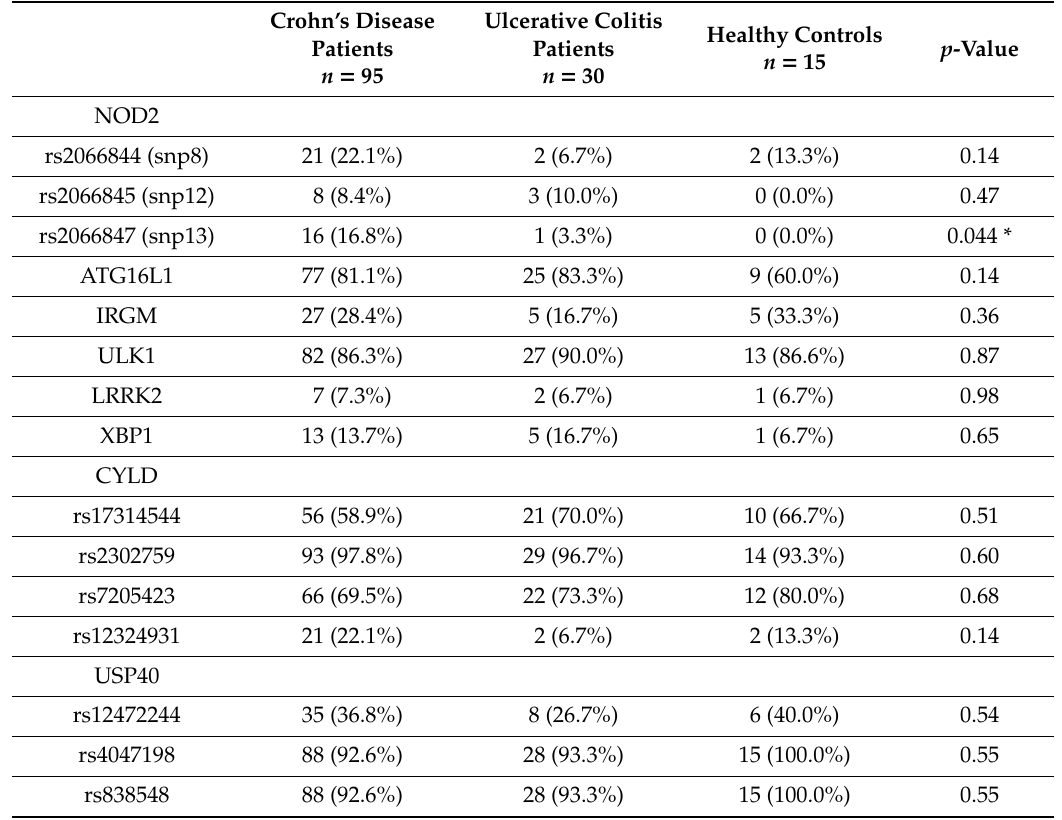
Table 2. Prevalence of the CD-associated polymorphisms investigated in the